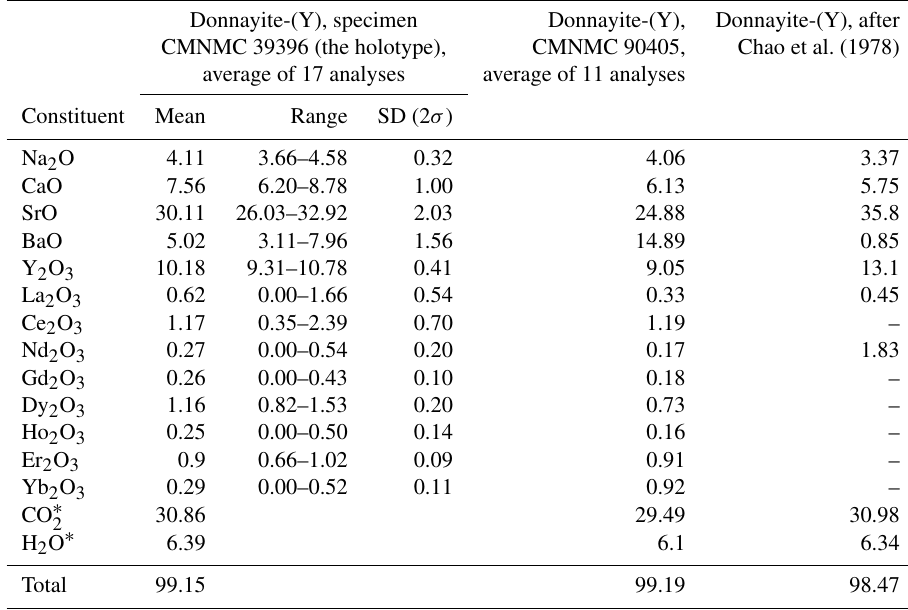
Table 2. Chemical data (in wt%) for donnayite-(Y) in comparison with data from Chao et al. (1978). Donnayite-(Y), specimen Donnayite-(Y), Donnayite-(Y), after CMNMC 39396 (the holotype), CMNMC 90405, average of 17 analyses